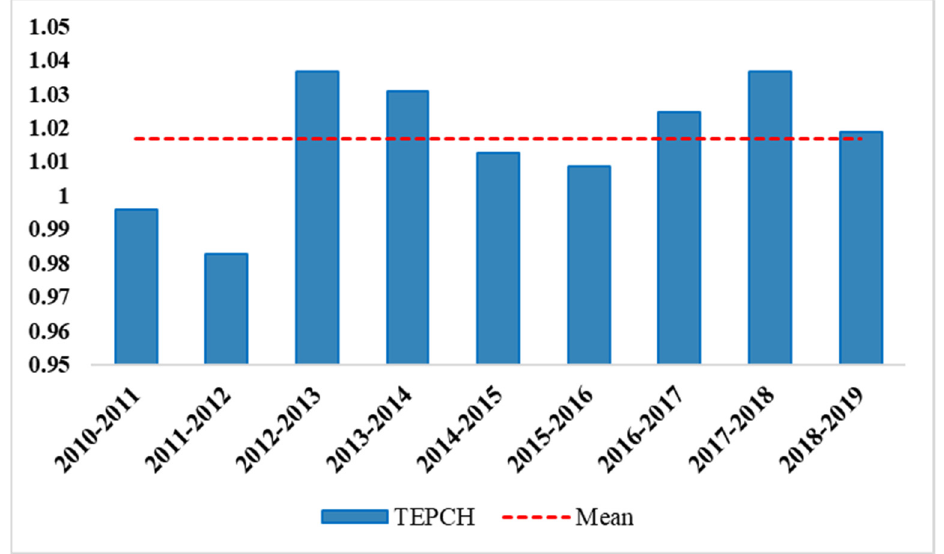
Figure 6. The changes in the total factor productivity (TFPCH) from 2010 to 2019.